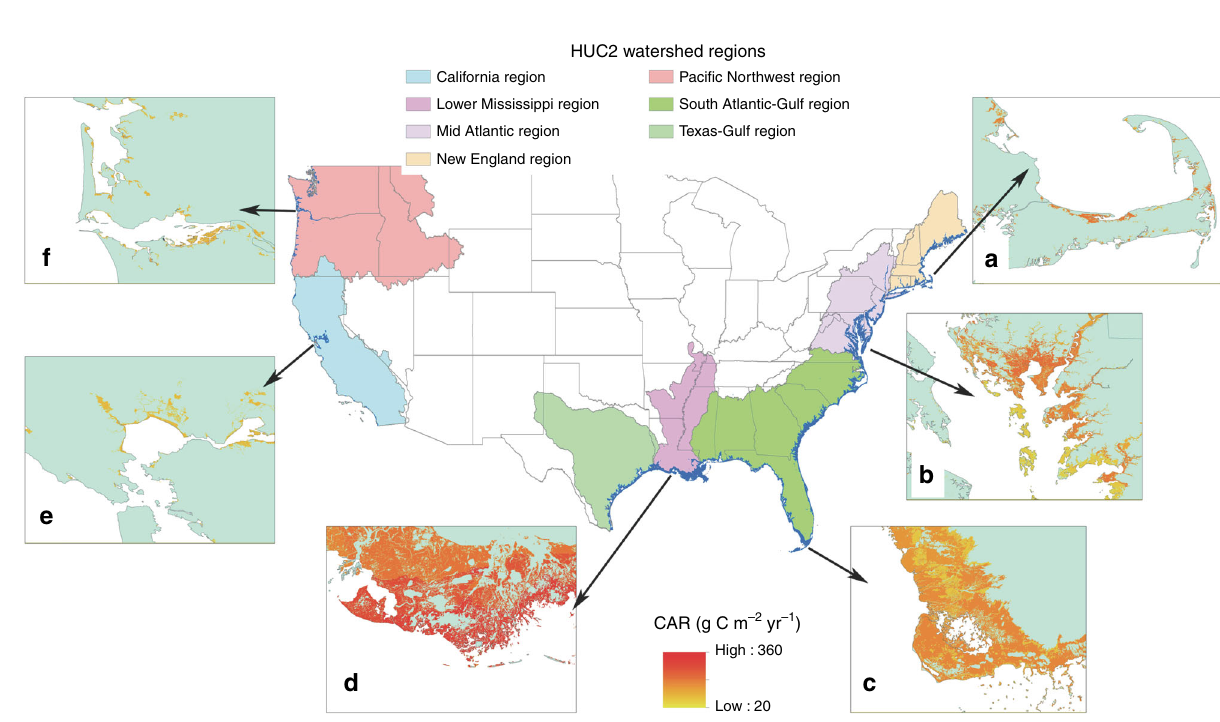
Fig. 1 The tidal wetlands distribution (blue color) on the seven watershed regions along the conterminous United States and C accumulation rates (CAR) of tidal wetlands in six selected regions. a Cape Cod in Massachusetts, b the Chesapeake Bay in Maryland, c southern tip of Florida, d the Mississippi River Delta in Louisiana, e the Bay Area in California, and f the Columbia River Delta in